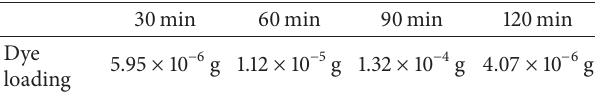
Table 2: Dye loading of ZnO nanowires with different growth